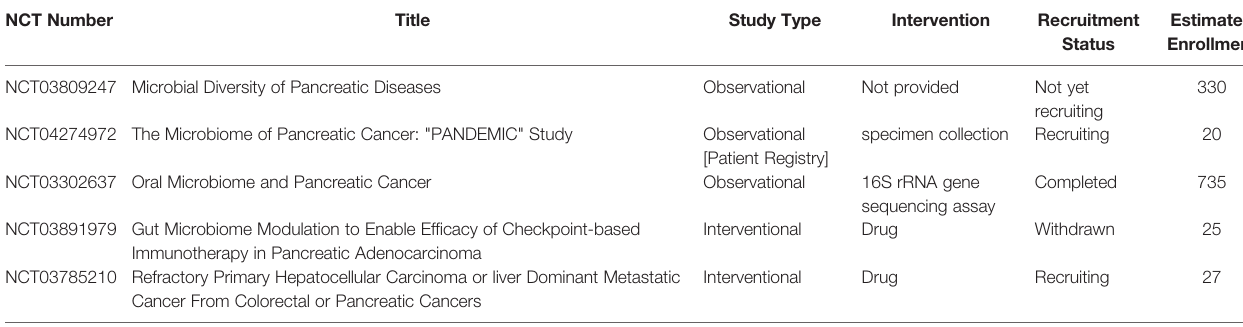
TABLE 3 | Representative clinicals of microorganisms in pancreatic